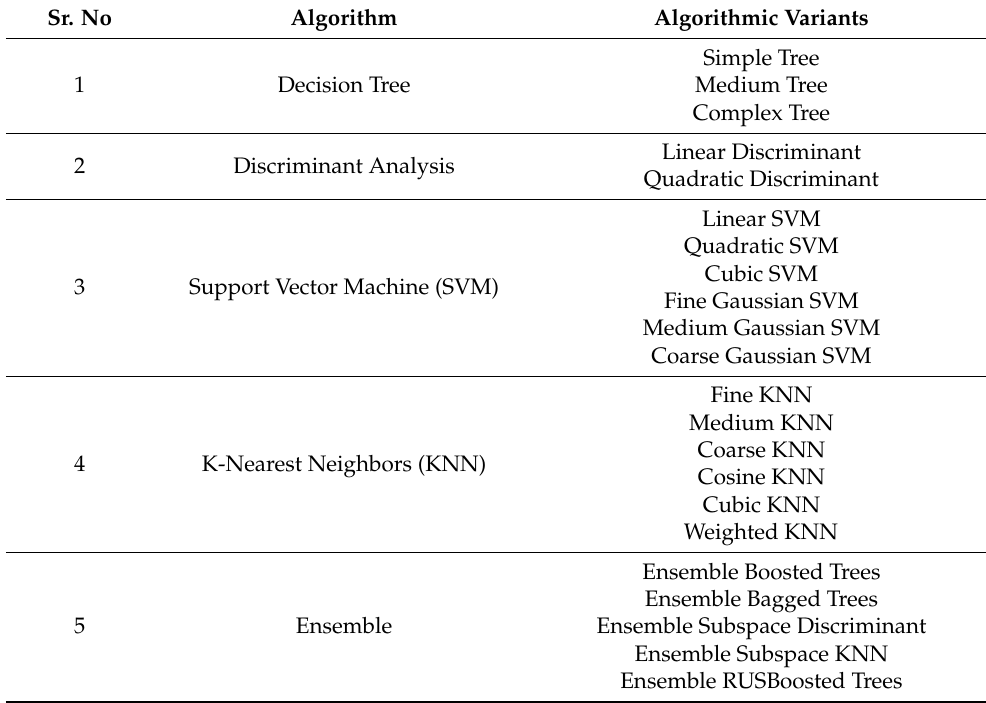
Table 3. Machine learning algorithms with